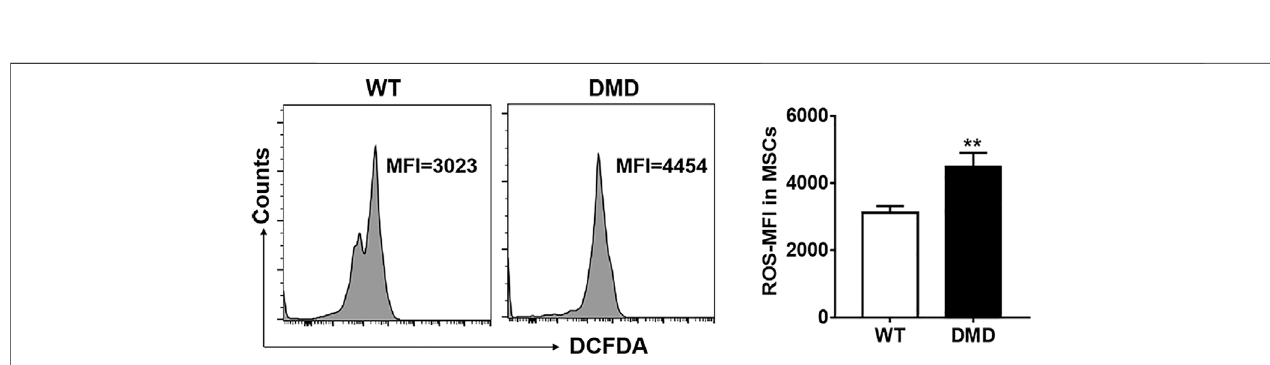
FIGURE4 | Changesof oxidizing free radicals in muscle stem cells ofDMD mice.Free radicals were detectedby fl owcytometry using the DCFDA probe in muscle stem cells (left panel). The changes of ROS levels in muscle stem cells of WT and DMD mice were compared ( n = 6, right panel). ** p < 0.01.